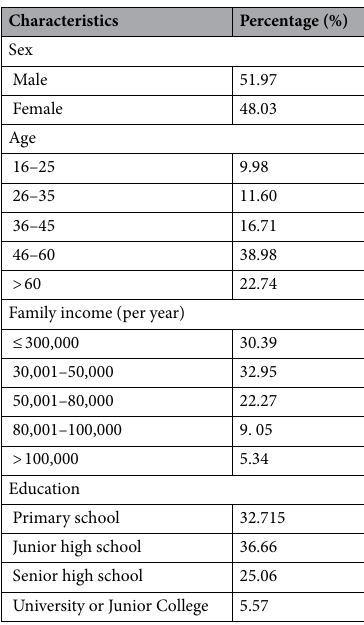
Table 1. Characteristics of the sample (N = 431).